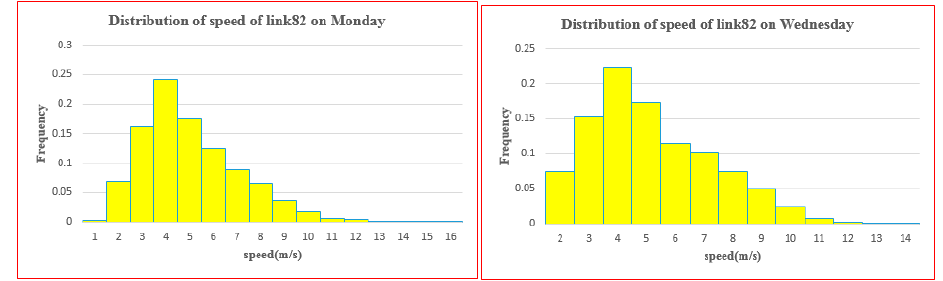
Figure 6. Distribution of speeds among the observations of link 88 on Monday and Wednesday.